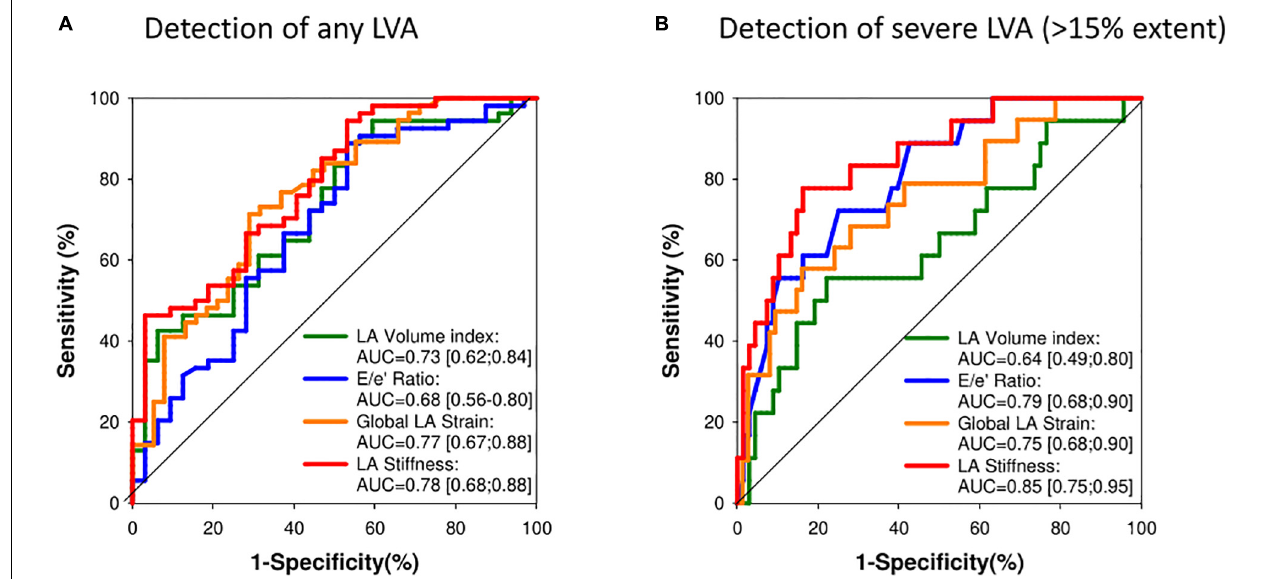
FIGURE 3 | (A) Receiver-operating characteristic curve analysis for prediction of presence of any LVA during EAM (Groups II and III). AUC, area under the curve; p < 0.05 Global LA strain vs. E/e (cid:48) ratio. (B) Receiver-operating characteristic curve analysis for prediction presence of important LVA extent (Group III LVA > 15%) during electroanatomical mapping (EAM). AUC, area under the curve; p < 0.05 LA strain vs. LAVI.